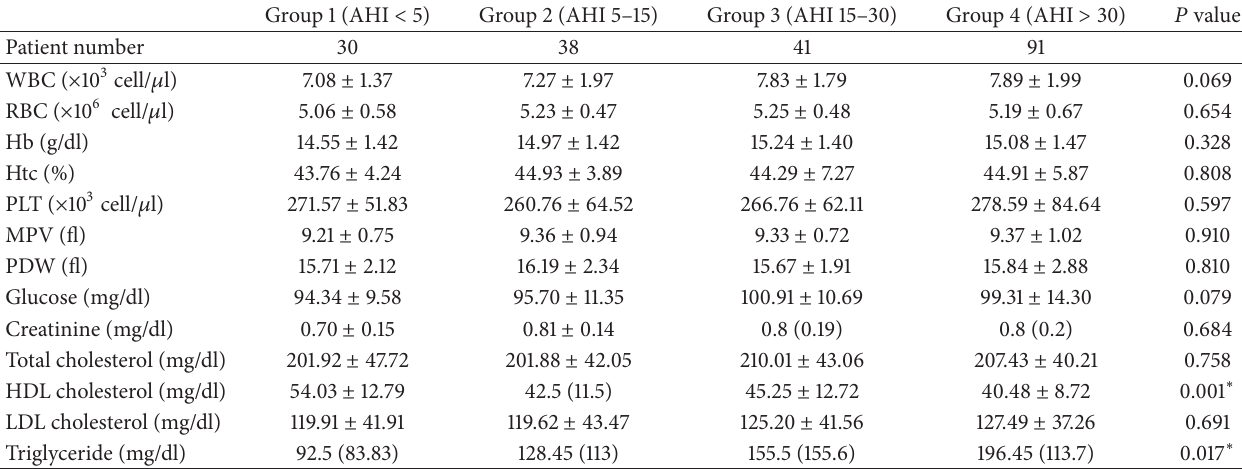
Table 3: Full blood count and biochemical characteristics of the